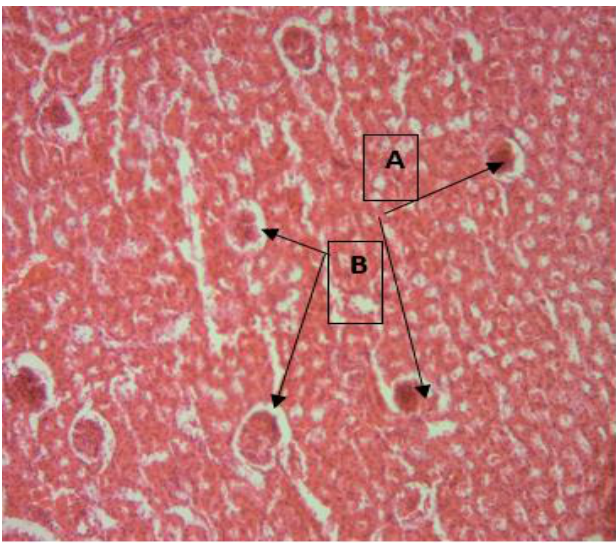
Fig. 1.2. Photomicrograph of a kidney showing shrinkage of the Fig. 1.3. Photomicrograph of a kidney showing solid cord-like tubules glomerulus (A) and dilatation of bowman’s space (B) (Test group 10X). (A), inflammatory infiltrate (B) and focal hemorrhage (C) (Test group